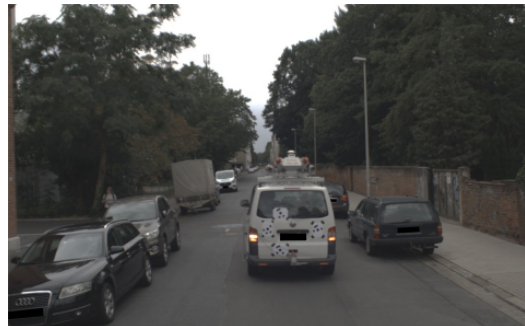
Figure 4. Image taken by one of the cameras of the vehicle at the beginning of the trajectory; the vehicle corresponding to the dynamic GCP can be seen in the centre of the